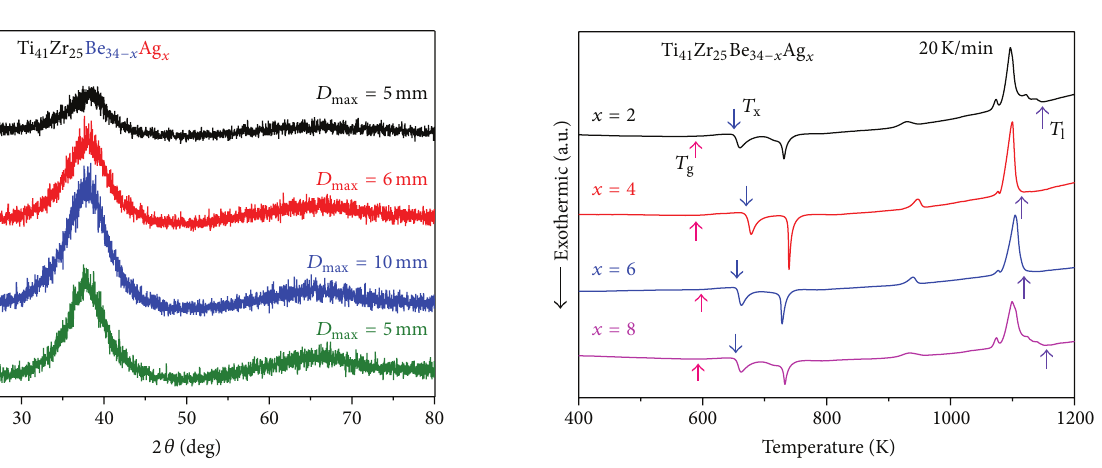
Figure 2: DSC curves of the Ti 41 Zr 25 Be 34− glassy